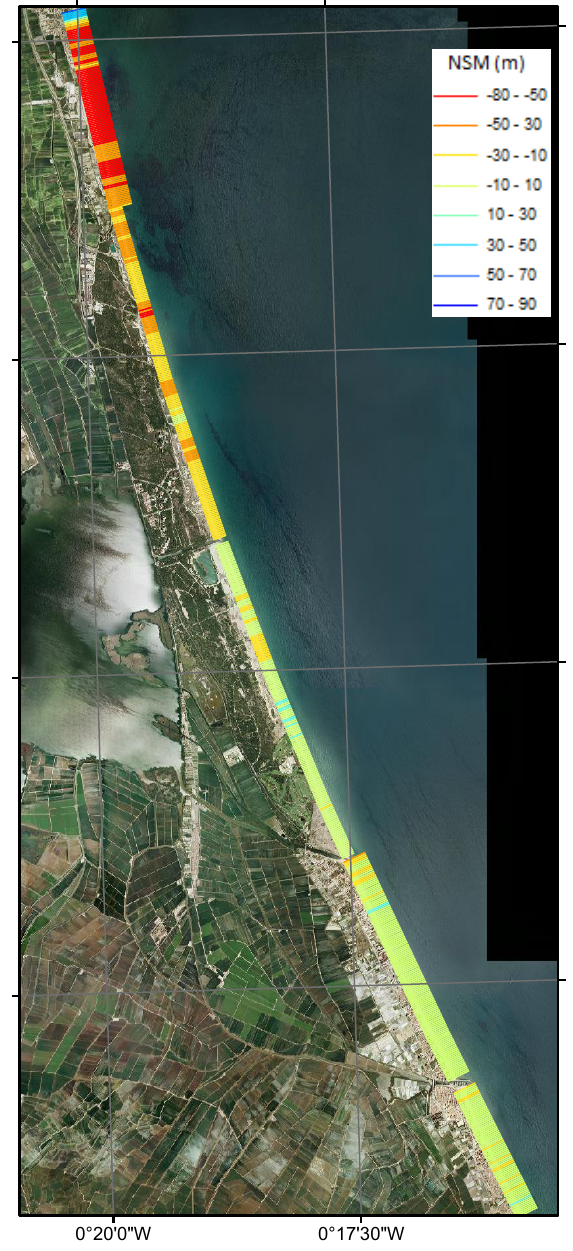
Figure 8. Cartography of the 743 transects covering the sector B and showing the evolutionary trend (Net Shoreline Movement) that have suffered the coast during the period 1984-2011. The smallest width of the central transects distinguishes the sector A, where the quality assessment of Landsat was done, to the evolutionary study in sector B. The information is shown over an orthophoto taken from PNOA sources in 2008.